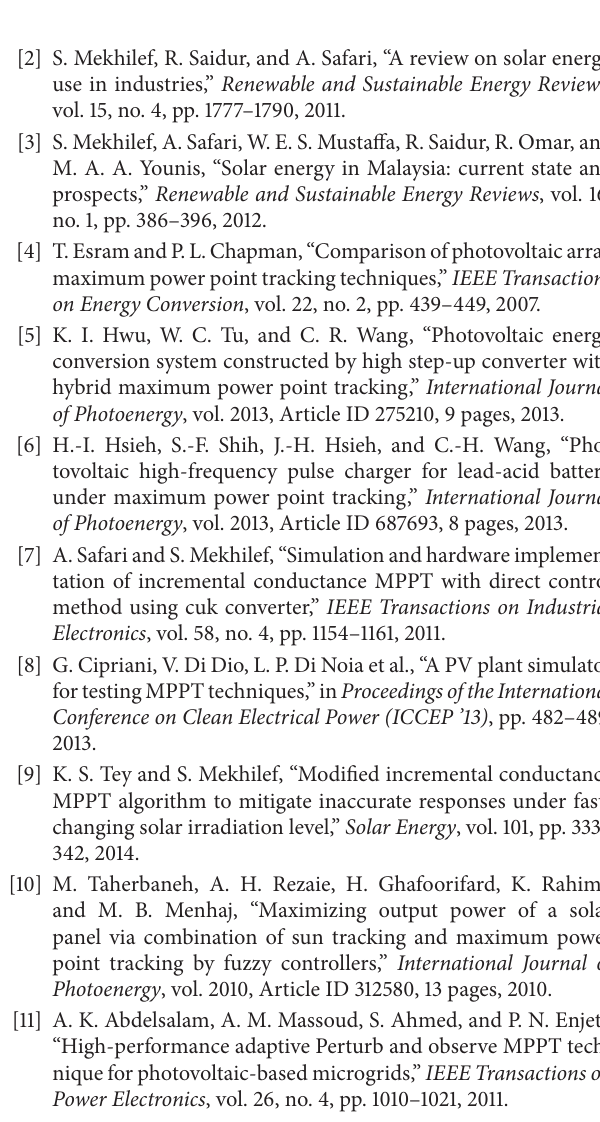
Figure 11: Experimental results for load variation under partial shading of 1.0kW/m 2 , 0.8 kW/m 2 , 0.7 kW/m 2 , and 0.6 kW/m 2 ; (a) proposed algorithm and (b) P&O.